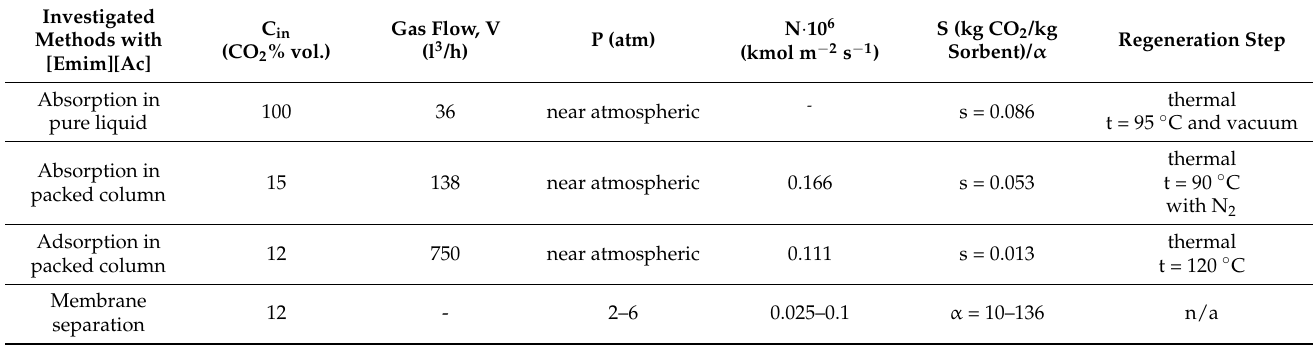
Table 3. Comparison of process parameters for the investigated methods of CO 2 removal at 40 ◦ C and atmospheric